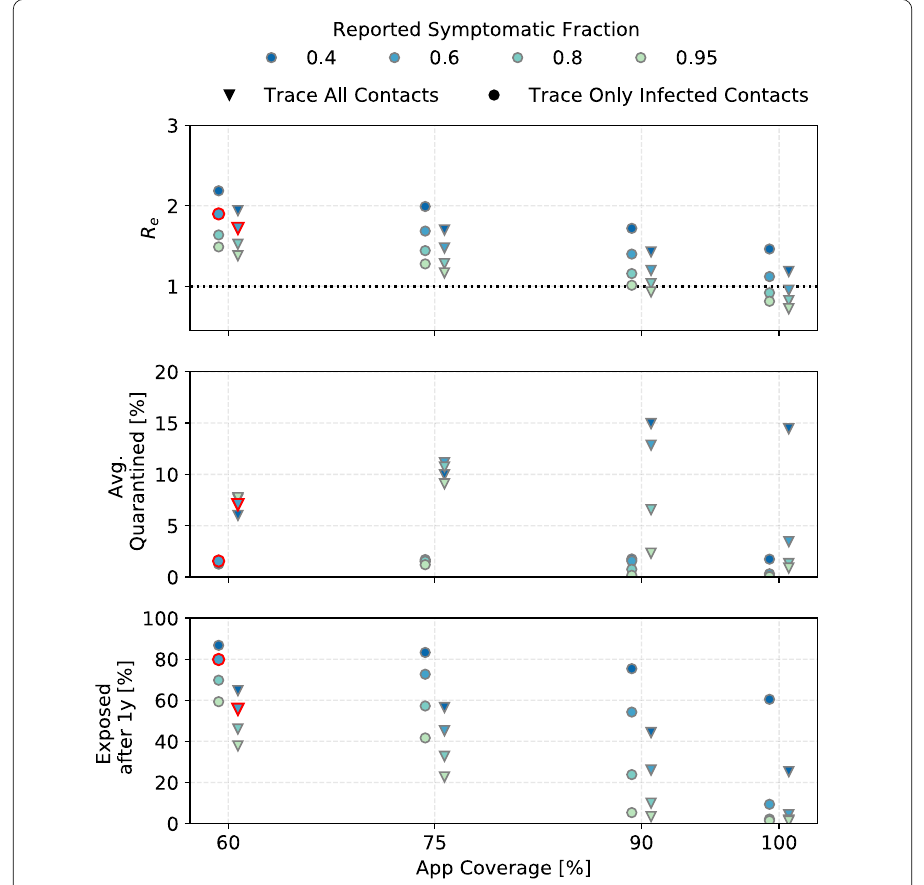
Figure 7 The effect of α · f m (tested symptomatic fraction) for different app coverages on the reproductive number after interventions (DCTS and quarantine) (top), the average of daily quarantined people as a percentage of the total population (middle) and the percentage of the population exposed after 1 year of continuous interventions (bottom). The points for 60% app coverage and 60% symptomatic fraction, outlined in red, will be studied further. This is for R 0 = 3 and η DCT = 1